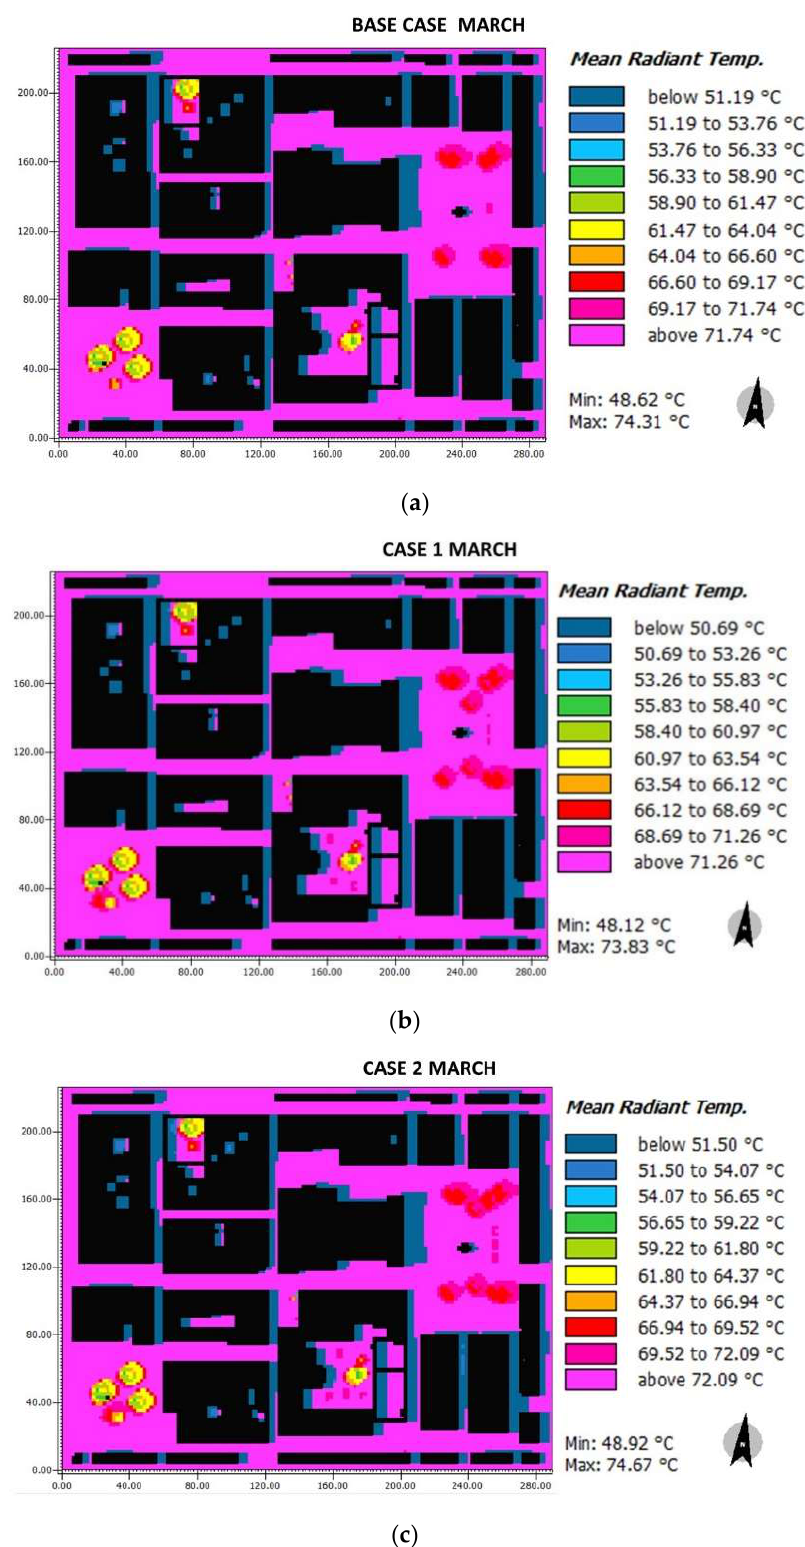
Figure 13. Results maps for radiant mean temperature for March at 15:00: ( a ) base case, ( b ) case 1, and ( c ) case 2.